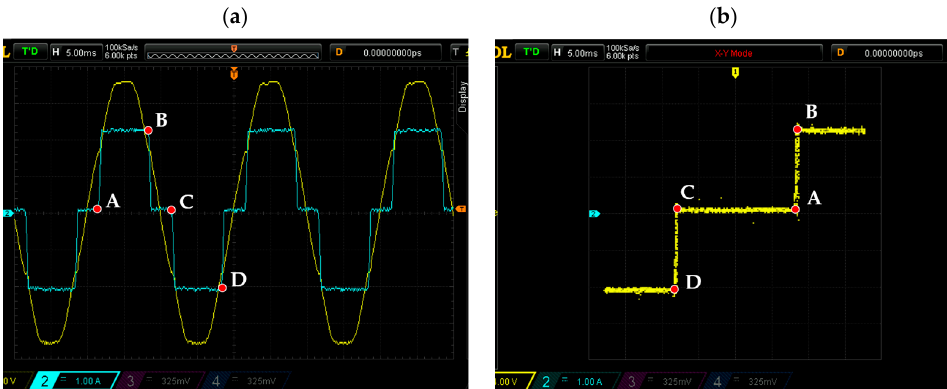
Figure 10. Top side of the assembled three-phase uncontrolled rectifier model with source and load schematic added ( a ) and industrial block rectifier IXYS VUO 110-12 NO7 used in the assembled model ( b ).